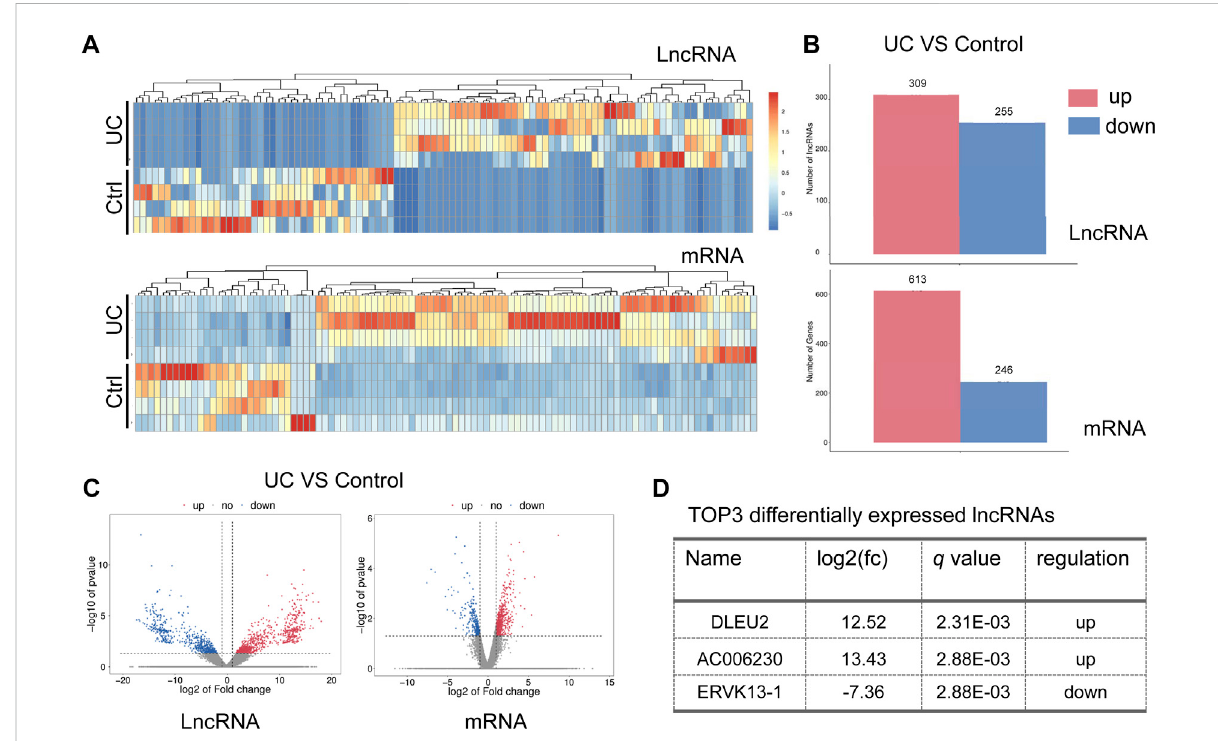
DLEU2 is up-regulated in UC patients. (A) The clustering heat map of the differentially expressed lncRNAs and mRNAs. (B) The barplot map of the differentially expressed lncRNAs and mRNAs. (C) The volcano map of the differential expressed lncRNAs and mRNAs. (D) TOP three differentially expressed known lncRNAs. Control, ctrl.